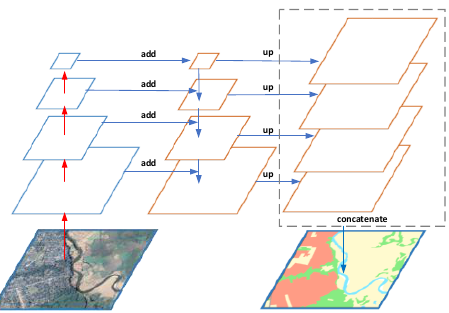
Figure 1. FPN architecture for land cover classification from satellite imagery. The decoder part (shown in orange) of FPN consists of a feature pyramid with 4 pyramid levels, and each pyramid level is up-sampled to generate layers with size of 1/4 input image size. And then they are assembled and up-sampled to generate segmentation mask.